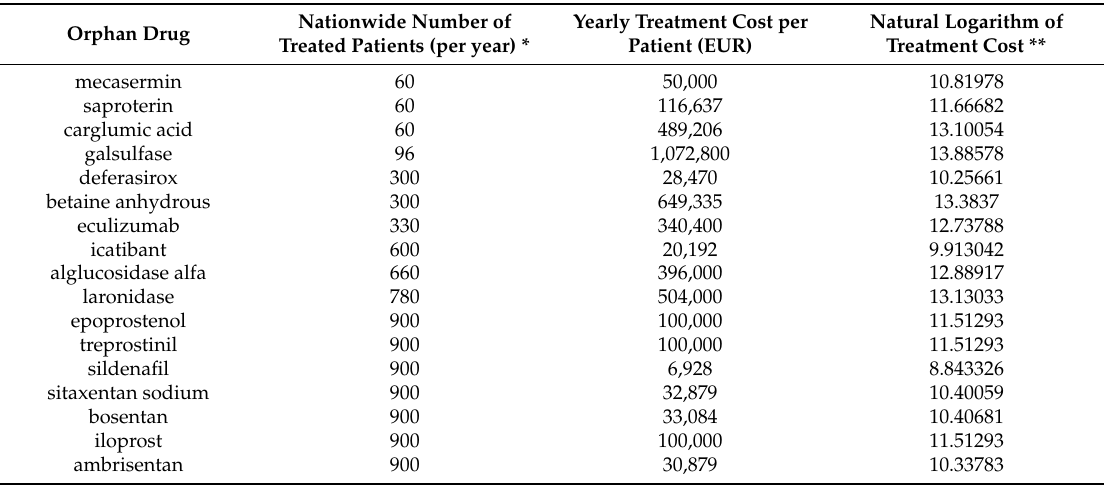
Table A1. Detailed information on the 17 data pairs of treatment cost-vs.-patients published by Fadda and Messori [2] for a series of orphan drugs